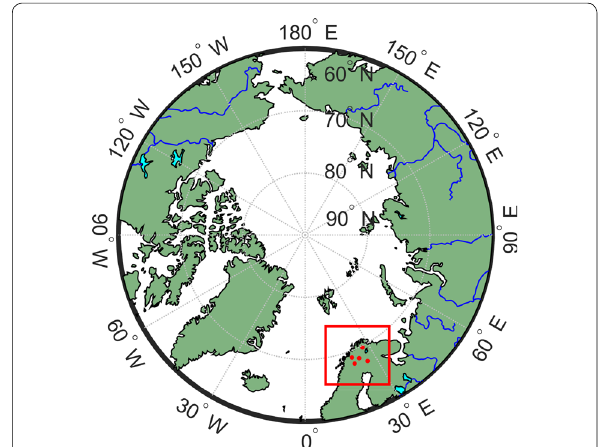
Fig. 1 Localization of the experimental network. The employed GNSS stations are depicted with red